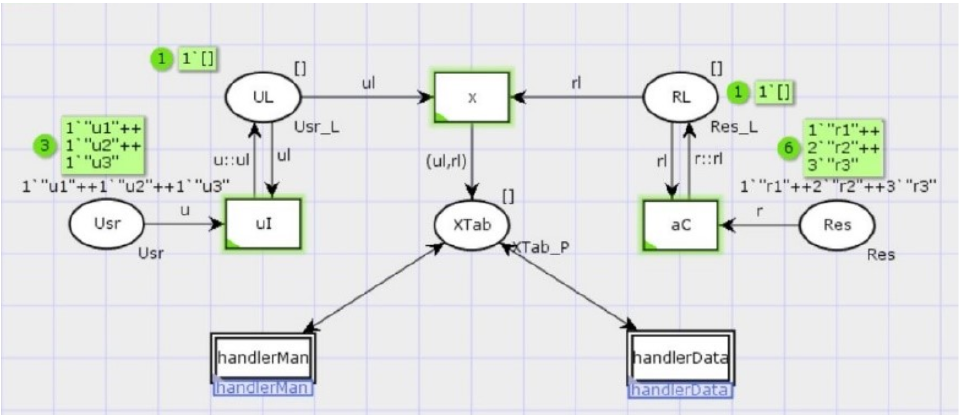
Figure 3. Top-level module of SCAC in a hierarchical CPN